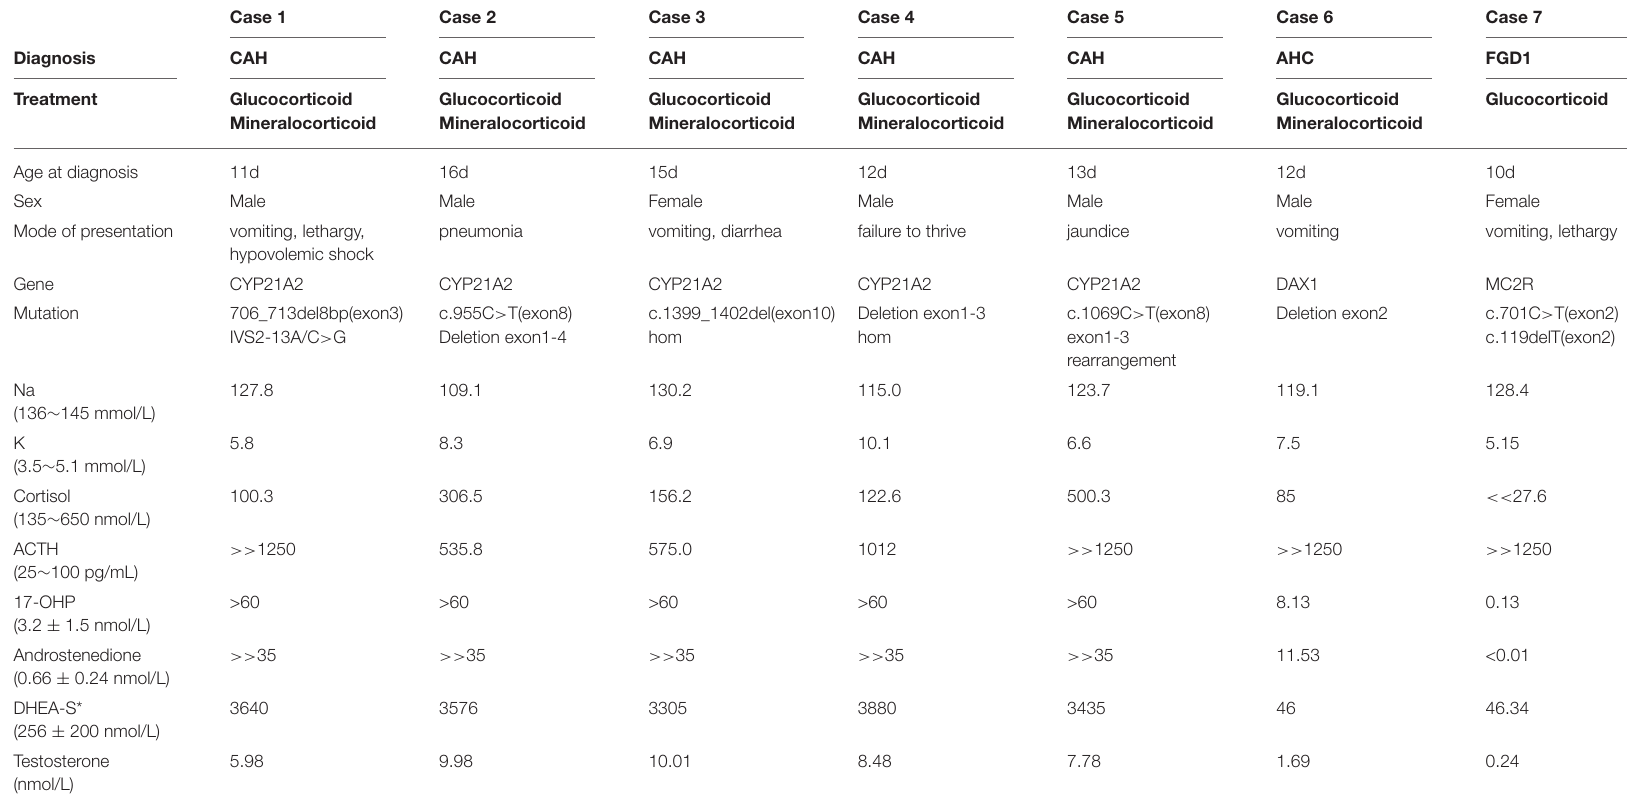
TABLE 2 | The clinical data, mutation spectrum, and laboratory results in the seven consulters diagnosed with